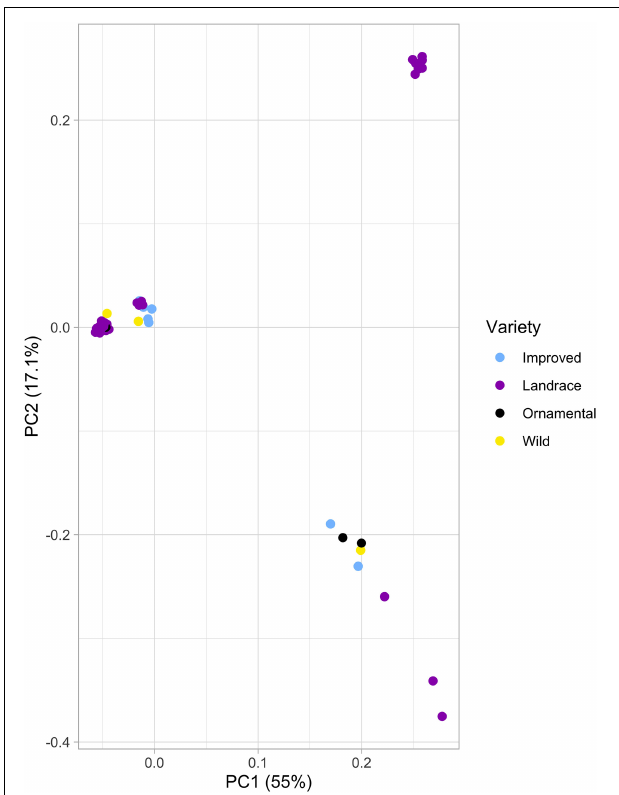
FIGURE 2 | PCA graph of the 2,061 SNPs. Mexican landraces in purple, accessions of C. pepo ssp. fraterna in yellow, accessions of C. pepo ssp. ovifera var. ovifera in black and accessions of commercial cultivars in